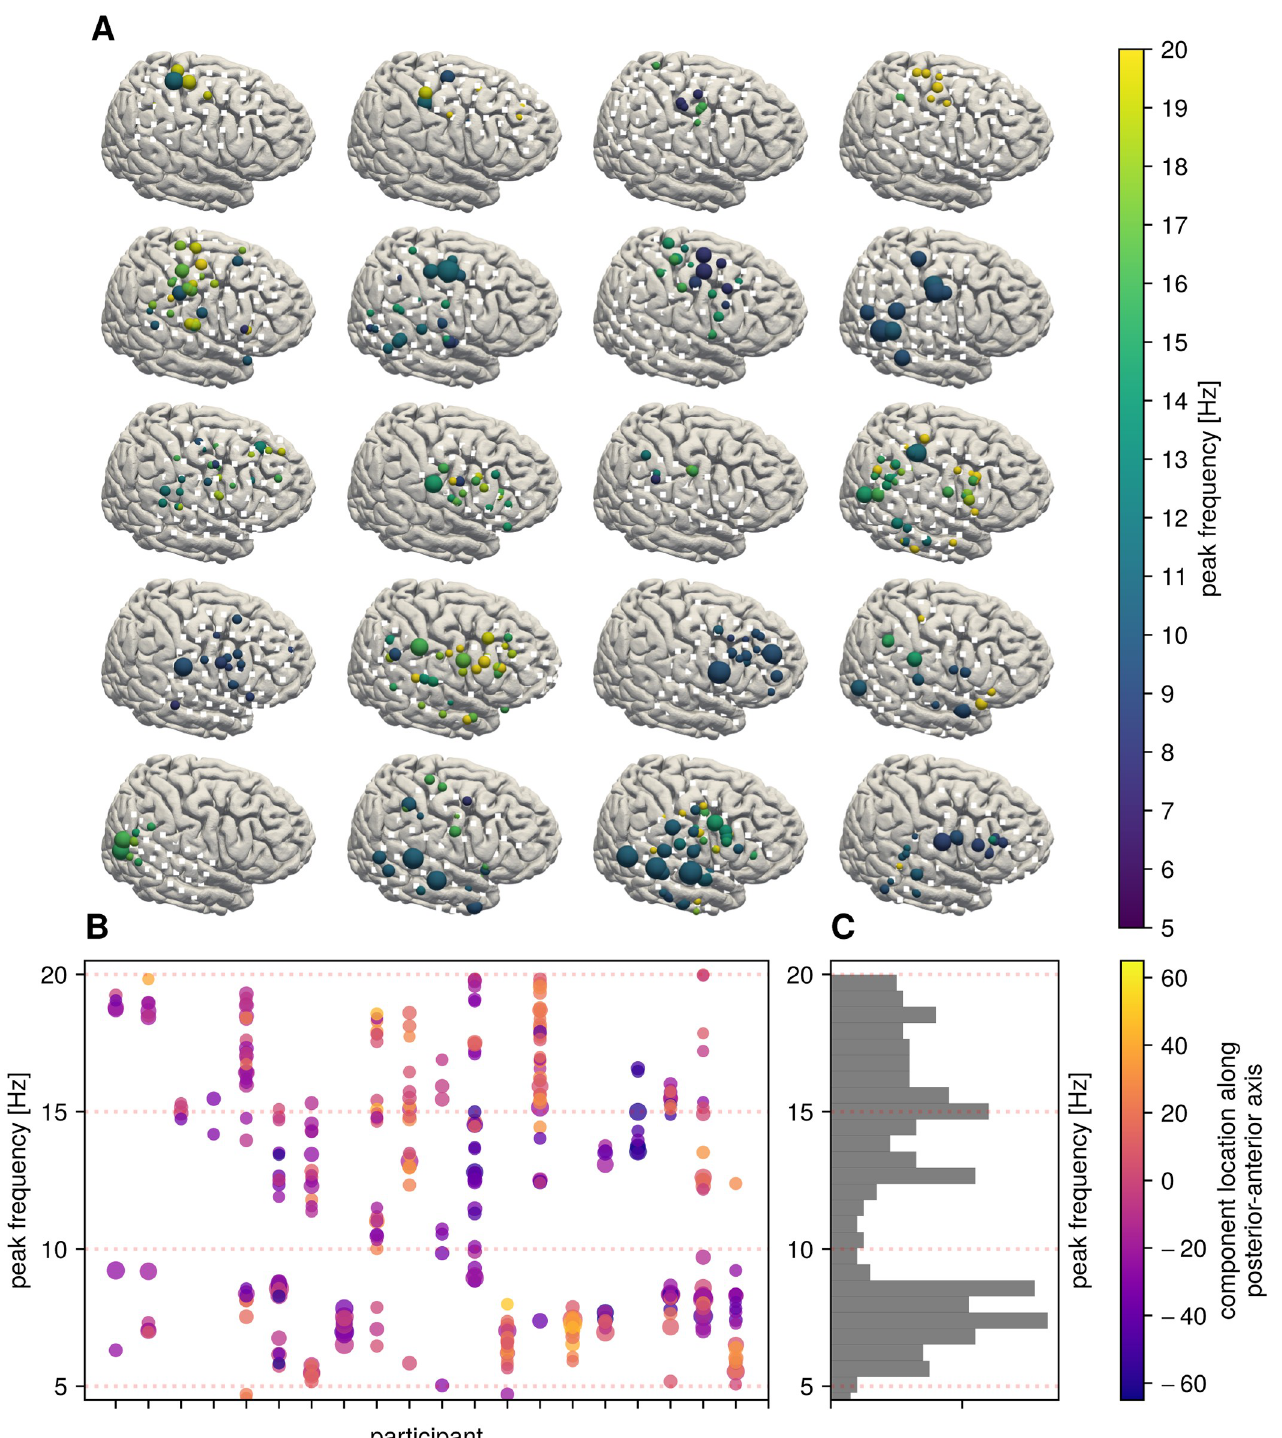
Fig 5. Variability of resting rhythms across the cortex. A) Each subplot shows the location of electrodes (white squares) on a template brain for one individual participant. Each sphere indicates an oscillatory component, with the size indicating 1/f-corrected SNR and the color indicating peak frequency of that component. If there is no sphere of a respective color in the vicinity of an electrode, no rhythm above the SNR-threshold could be detected in that frequency band. There is large variability between participants. For improved comparison across participants, all electrodes and rhythm locations were mapped onto the right hemisphere. Participants are ordered according to the mean z-coordinate across the electrode grid, to ease comparison. B) Each component is represented